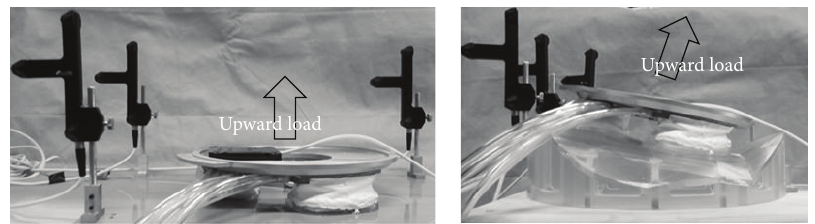
Figure 14: Experimental setup to evaluate the performance of the holding device.